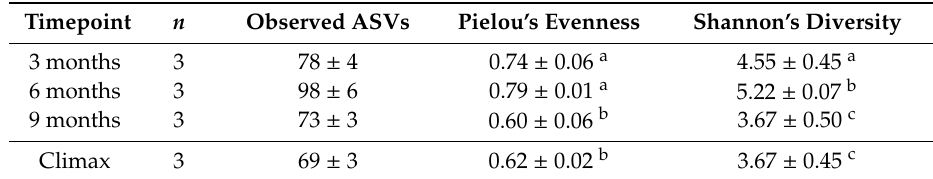
Table 1. Alpha diversity metrics of cyanobacterial endolithic communities in tiles placed in the intertidal zone of Isla de Mona and metrics from geographically similar natural substrate communities on Isla de Mona described by Roush et al.